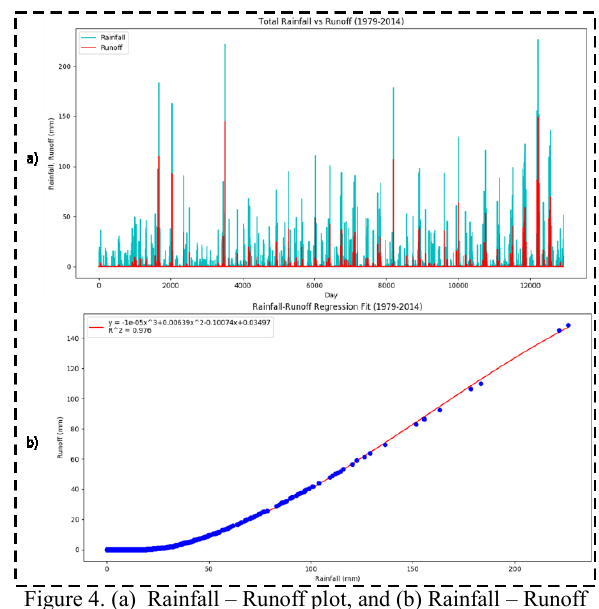
Figure 4. (a) Rainfall – Runoff plot, and (b) Rainfall – Runoff relationship over a span of 36 years (1979 –